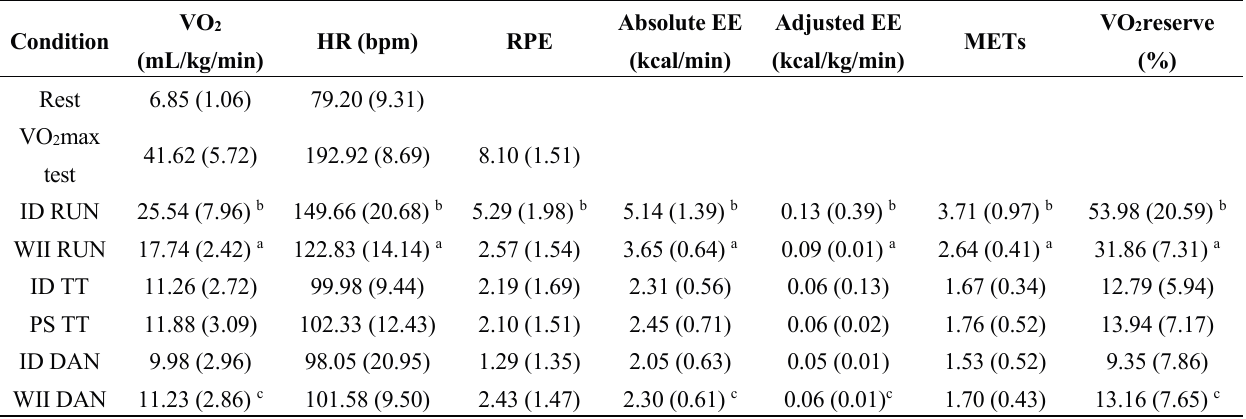
Table 2. Physical and perceptual responses for each